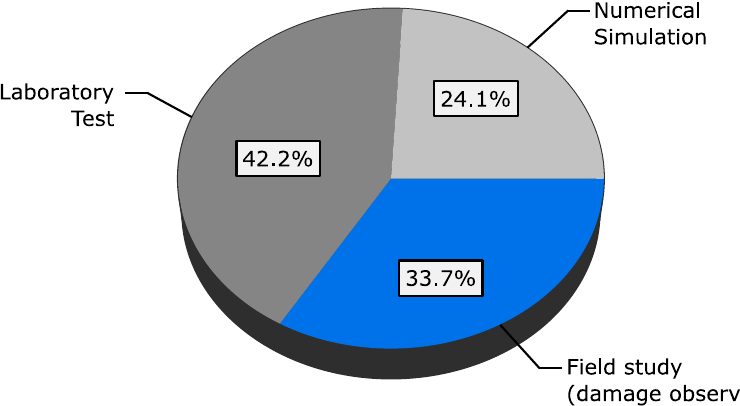
Figure 17. Percentage of the reviewed papers using datasets from field studies, laboratory tests, and numerical simulations. If a paper involves multiple types of datasets, it counts towards field studies, if it has one. Otherwise, it counts towards laboratory